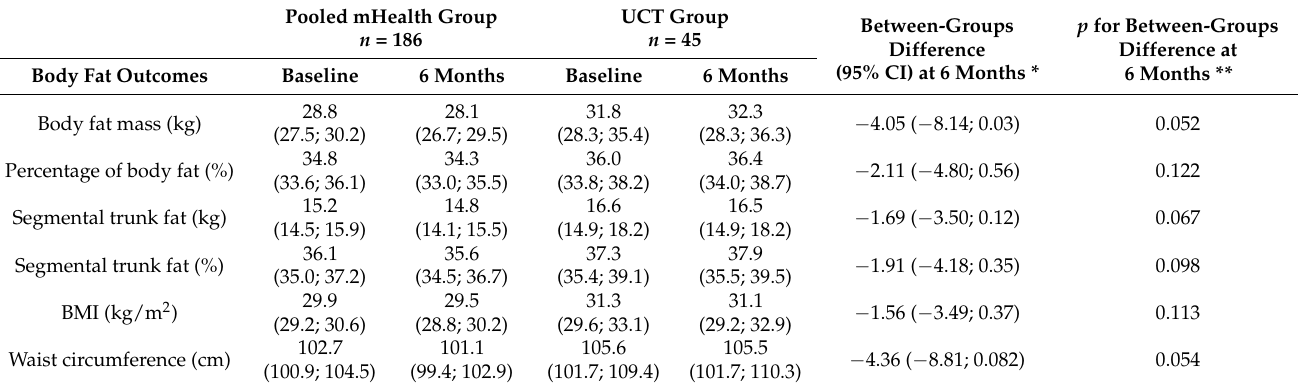
Table 3. Baseline and follow-up anthropometric characteristics and between-groups difference at 6 months [mean (95%